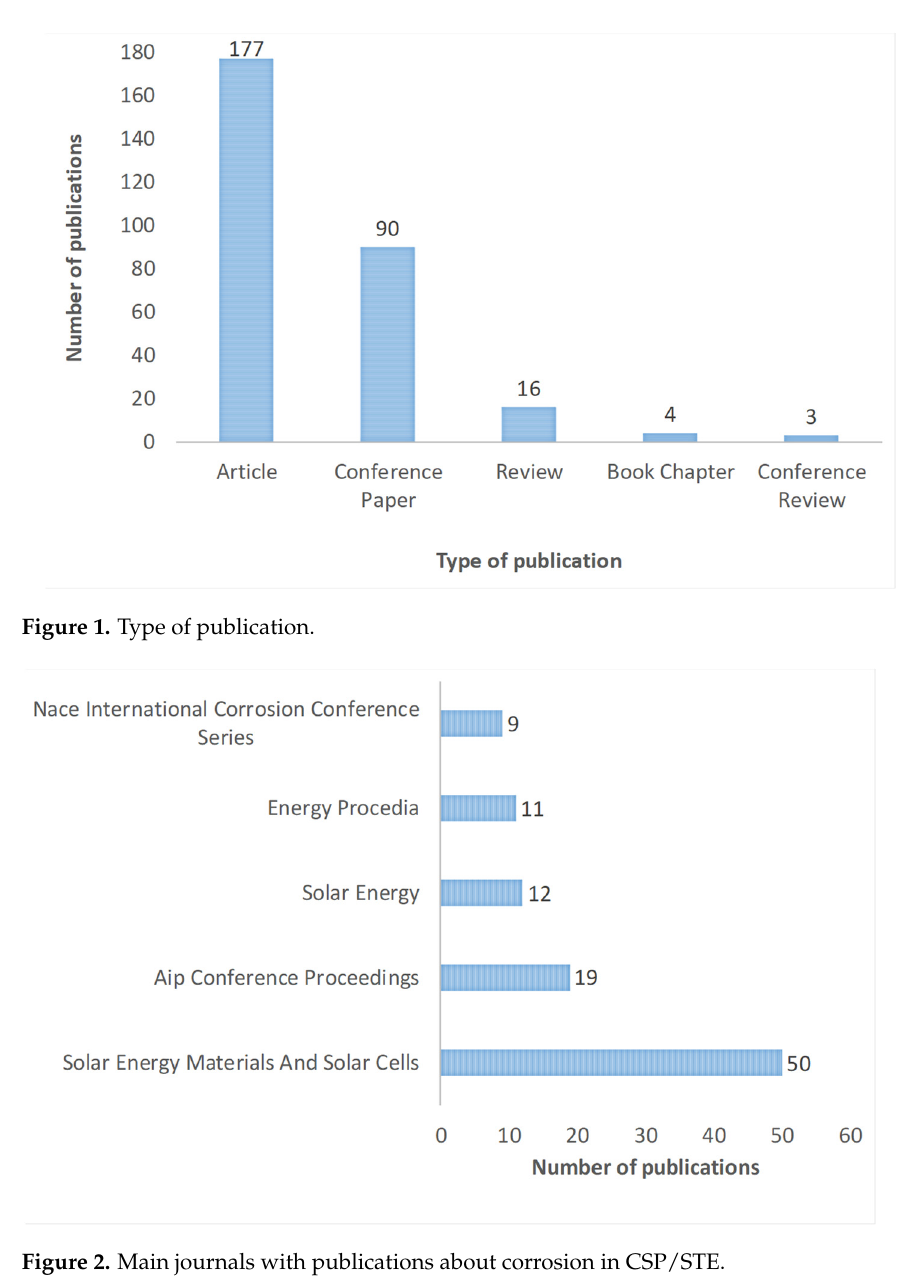
Figure 2. Main journals with publications about corrosion in CSP/STE.